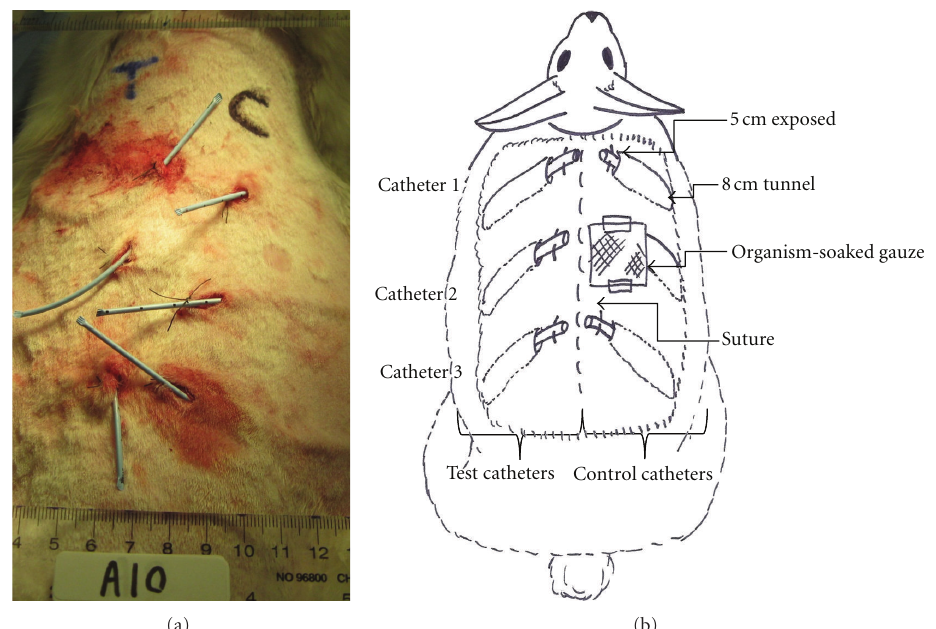
Figure 1: Left side image shows actual catheter placement (rabbit 10 shown) prior to challenge and bandaging. Right side is a cartoon diagram representing catheter placement and challenge procedures. The diagram displays only those portions of the device which are evaluated. Note that the test and control sides are randomized between animals and groups.